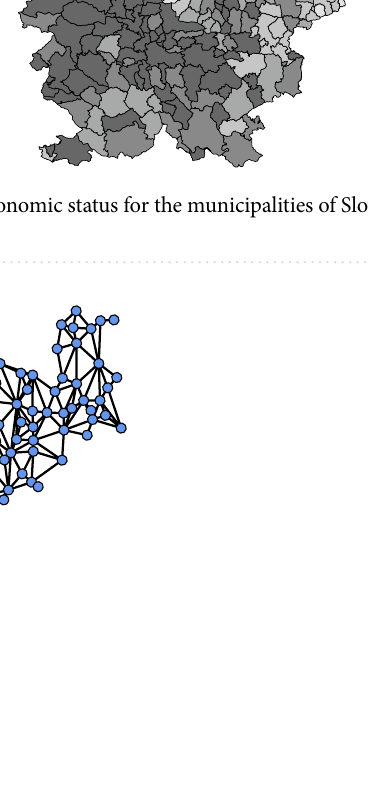
Figure 2. The adjacency structure G = ( V , E ) for the municipalities of Slovenia. Figure created using R